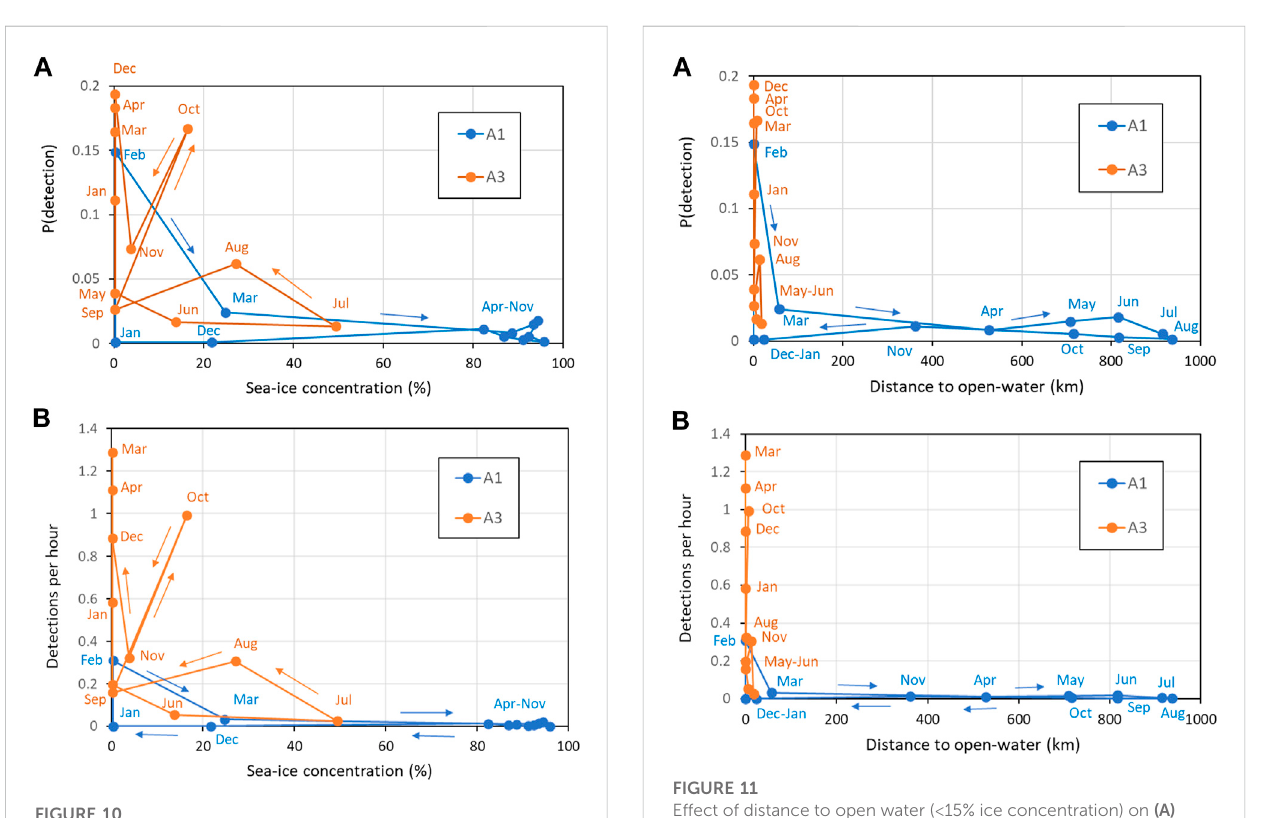
FIGURE 10 Effect of sea-ice concentration (30 km range) on (A) Mean probabilityofdetectioninanhour; (B) Meanhourlydetectionrate.Key months are labeled (see colour for site). Coloured lines connect months in date order as shown by the arrows.